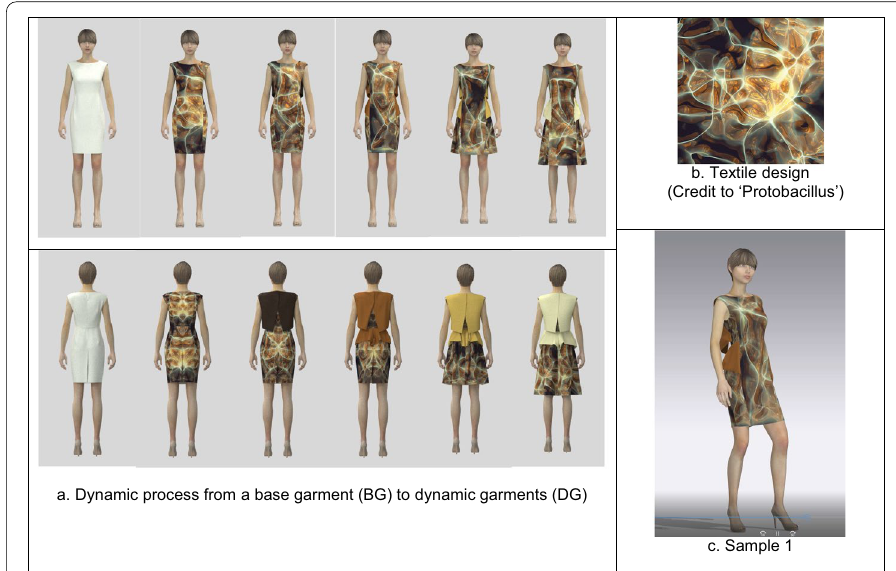
Fig. 1 The technical process to develop a 3D dynamic fashion garment (sample 1): a The moving images, b textile design (GIF), and c sample 1 (MP4) are available in Additional file 1